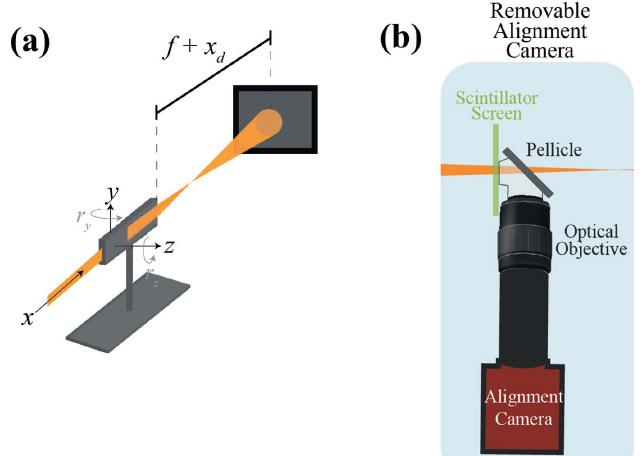
Figure 1 Schematic of the basic layout for the alignment detector, detailed in the blue box labeled Removable Alignment Camera, showing how it fits into a synchrotron experiment. We note that most of the detector optics can be customized based on the availability and beam parameters to set the magnification and field of view for the alignment